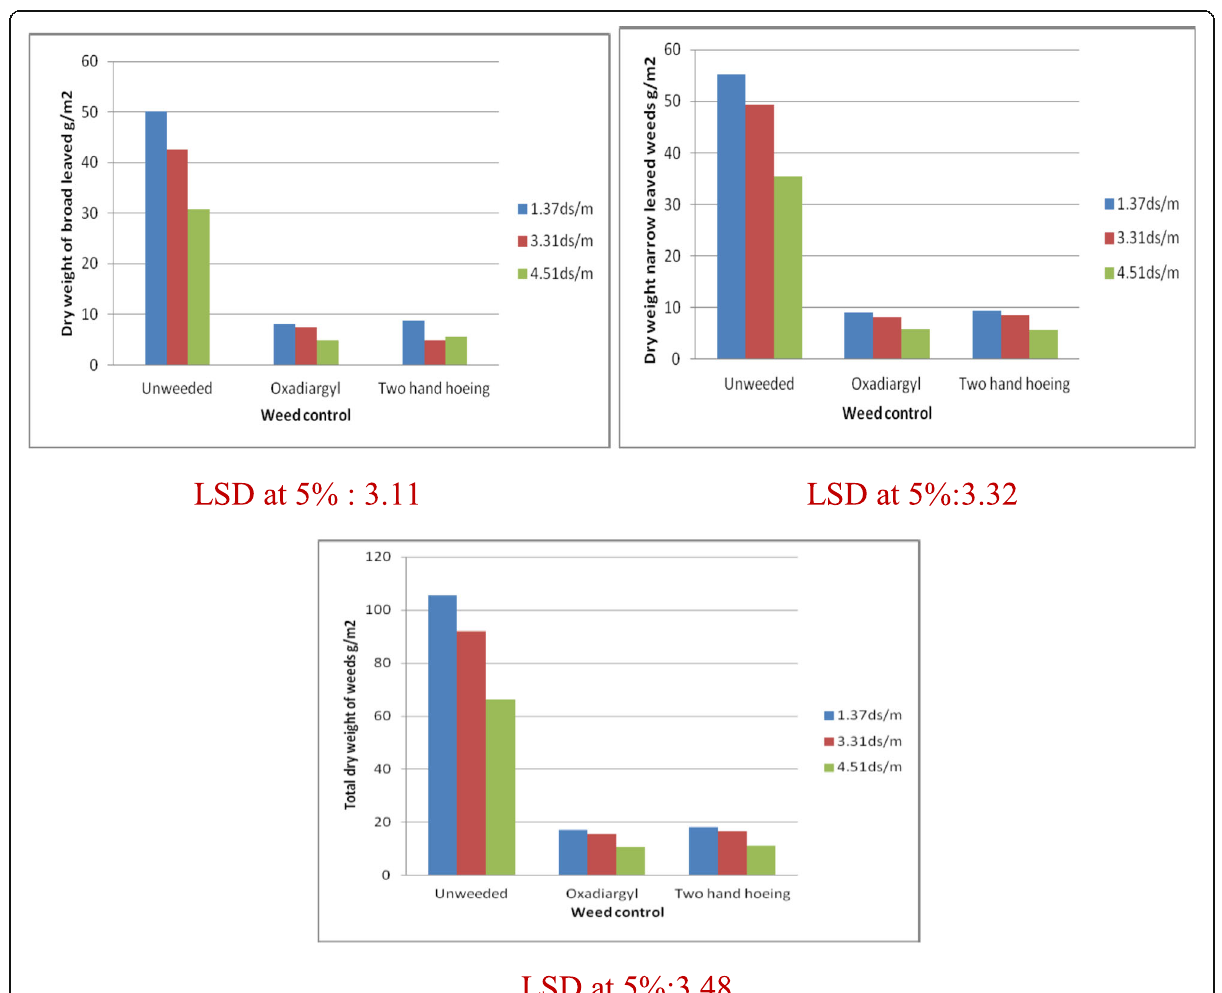
Fig. 1 Effect of the interaction between weed control and salinity levels on faba bean weeds dry weight (g/m 2 ) at 60 days from sowing (combined analysis of two